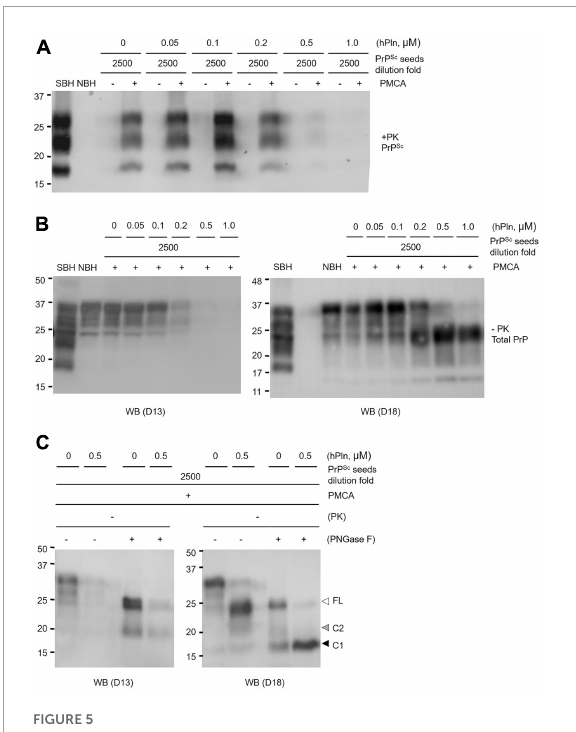
FIGURE5 Plasmin inhibits PrP conversion in PMCA by promoting α -cleavage. Sick brain homogenate (SBH) were diluted 2500-fold in uninfected normal brain homogenate (NBH) and used as PrP Sc seeds for PMCA. PMCA products were evaluated by western blot analysis. (A) PMCA was conducted with increasing concentrations of hPln ranging from 0 to 1 µ M and the level of PrP Sc was evaluated by western blot analysis with PK digestion. Pre- and post-PMCA samples are denoted by (-) and (+), respectively. (B) Post-PMCA (+) samples analyzed in Panel (A) were not subjected to PK digestion and further analyzed by western blotting with D13 or D18, recognizing full-length and fragments of PrP in different glycosylation states. (C) Post-PMCA (+) samples with no PK digestion from Panel (B) were deglycosylated by PNGase F and analyzed by western blot with D13 or D18. white arrow, full-length (FL) PrP; black arrow, C1 fragment; gray arrow, C2 fragment.